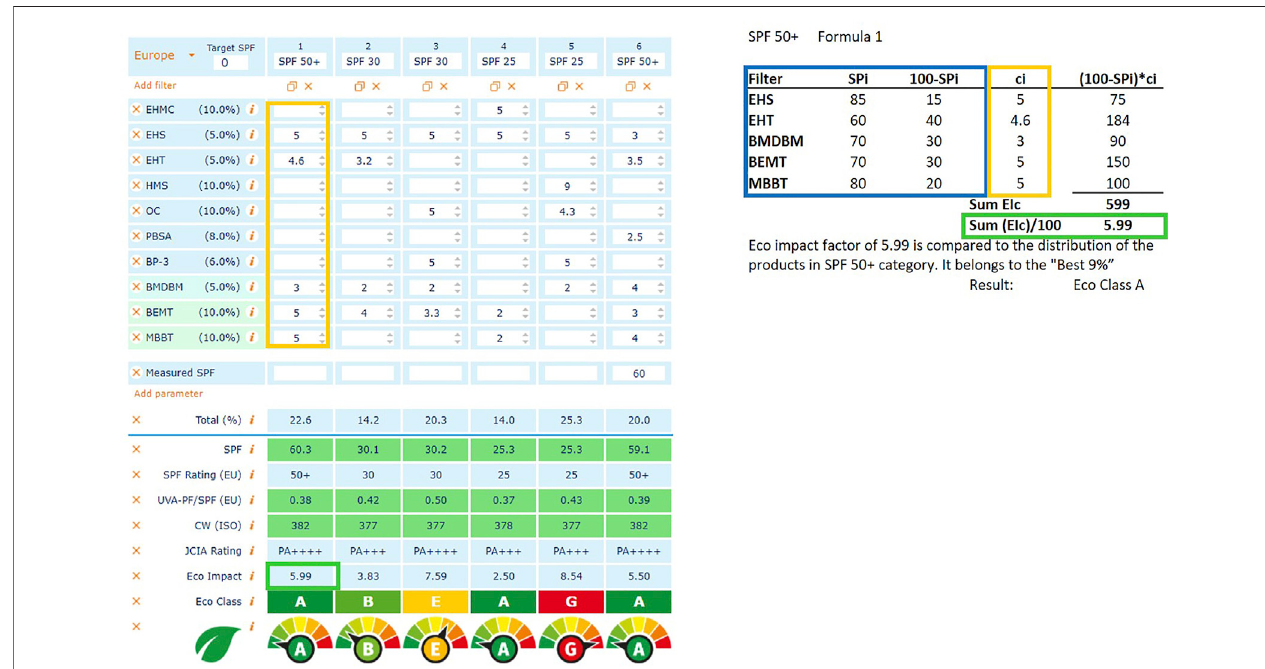
FIGURE5| ExampleofUV fi ltercombinationsandcalculationvaluesleadingtothecreationofanEcoimpactvalueandcorrespondingclassi fi cation.(Abbreviations used:seebelow),InsertedTable:Blueboxshowvaluesrelatedto Eq.1 ,OrangeFrame:Userinput/concentrationofindividualUVFilters,Greenbox:EIc-Resultusedfor classi fi cation according to Eq. 2